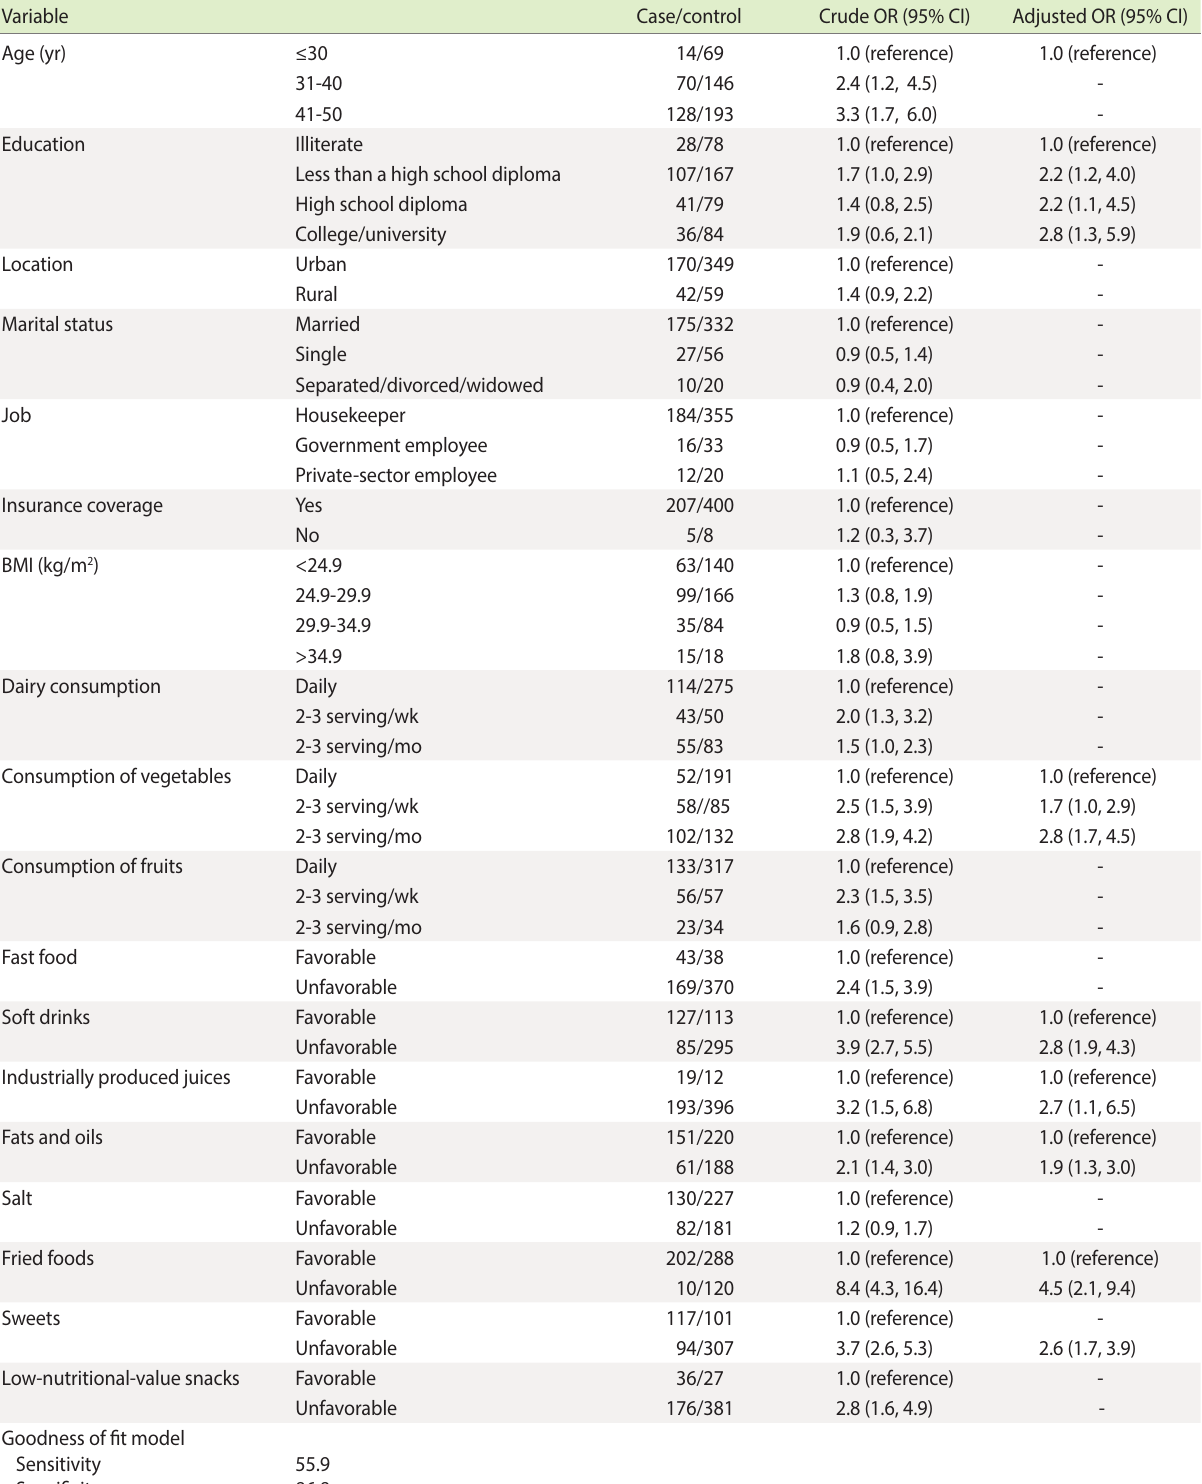
Table 2. Univariate and multivariate analysis of dietary patterns and risk of breast cancer